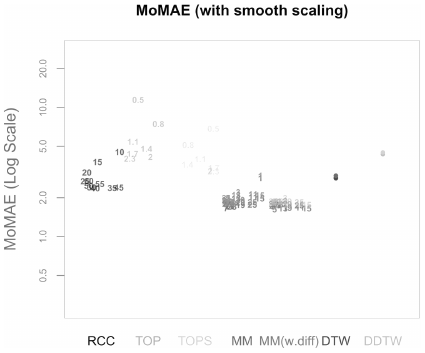
Figure 15. MoMAE with underlying smooth